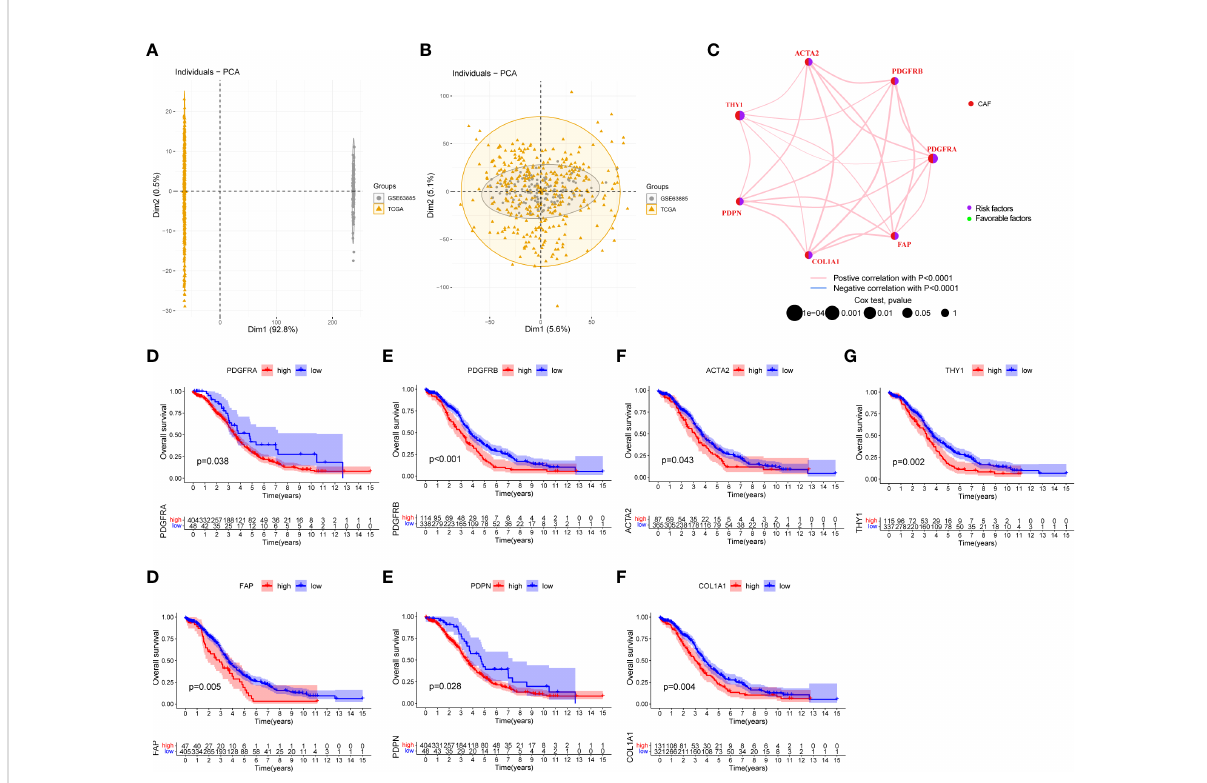
FIGURE 8 Survival analysis of seven CAF markers in the EOC cohort. (A) Before the removal of batch effects through principal component analysis, the differences between samples obtained from two datasets are illustrated. (B) After the removal of batch effects, the differences among samples obtained from two datasets are reduced. (C) Interactions and interconnection among CAF markers in EOC. The connecting lines represent their interactions, and the thickness of the lines indicates the strength of the association. The pink and blue lines represent positive and negative correlations, respectively. The green and purple dots in the circle indicate favorable and risk factors, respectively. (D – J) Survival analysis between seven CAF markers and overall survival in EOC